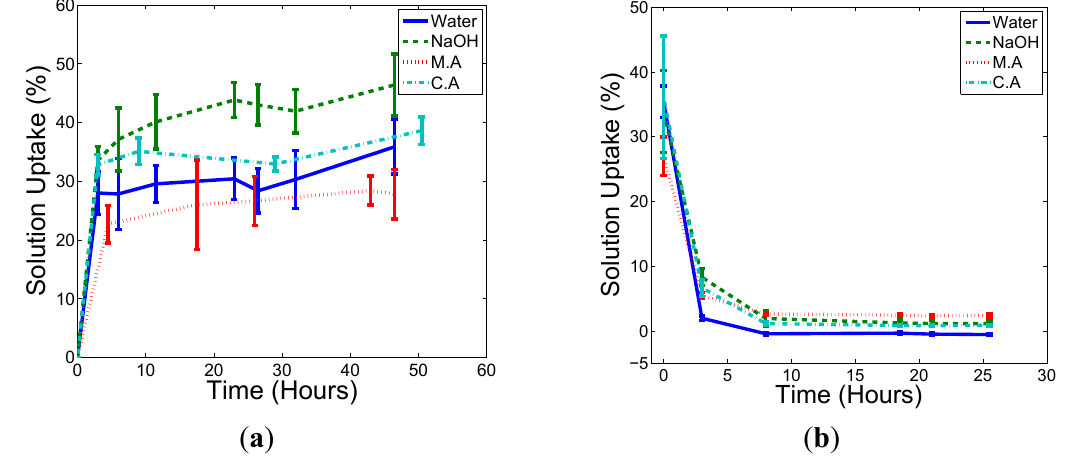
Figure 1. The rate of solution uptake ( a ); and subsequent moisture egress from saturation ( b ) for the CNFC rectangular samples.